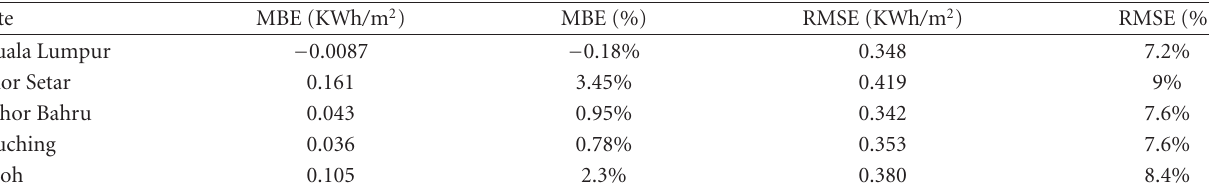
Table 5: MBE and RMSE for the five sites.